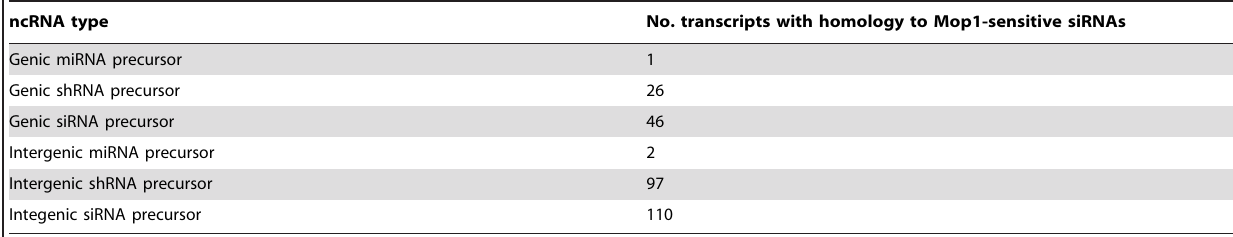
Table 4. ncRNAs with homology to Mop1-sensitive